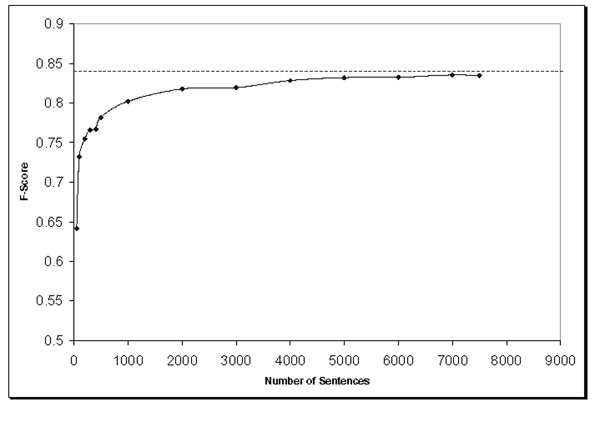
Learning curve. Learning curve for the performance of the "open" NER system on development data.